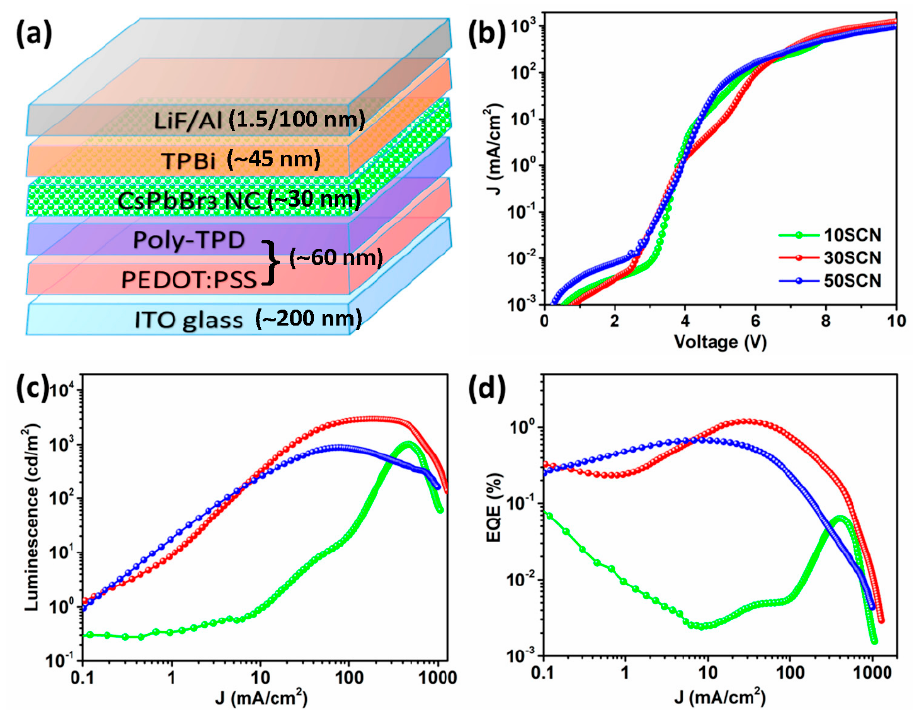
Figure 1. Characterization of LED performance. ( a ) Diagram of the LED structure; ( b ) current density as a function of driving voltage; ( c ) luminescence and ( d ) external quantum efficiency (EQE) as a function of current density in the NC LEDs.